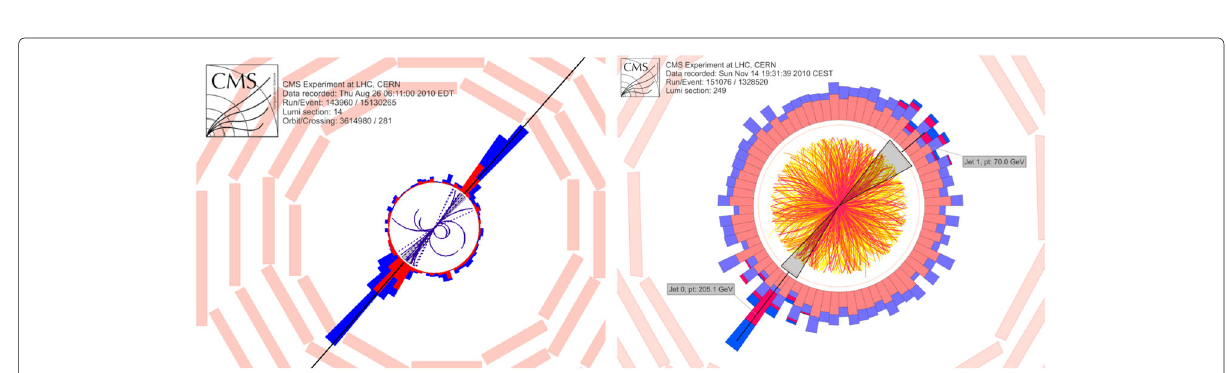
√ s NN = 2.76 TeV from the CMS experiment